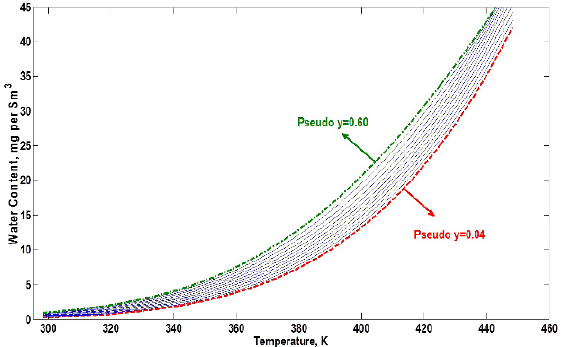
Figure 4. Prediction of water content of sour natural gases and acid gas mixtures at 21000 kPa (abs).